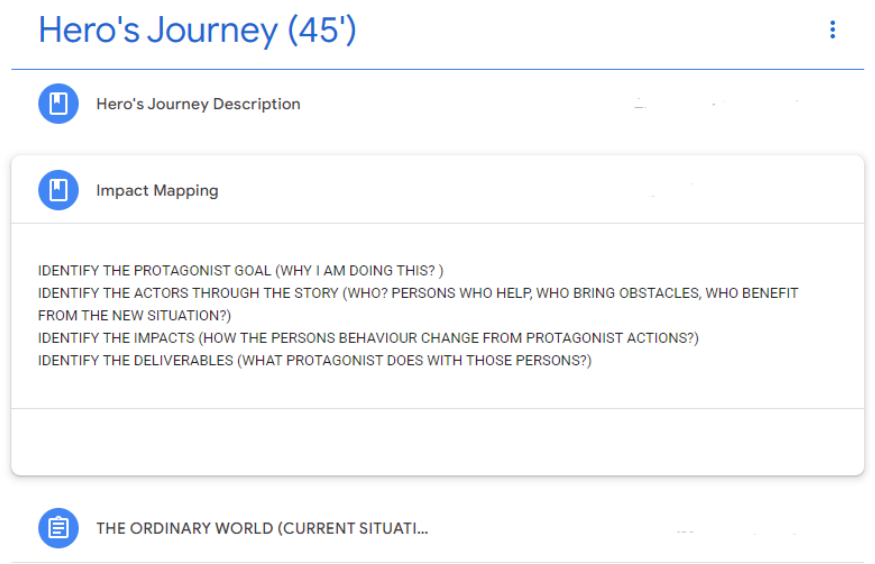
Figure 7. Creative narration and impact mapping.